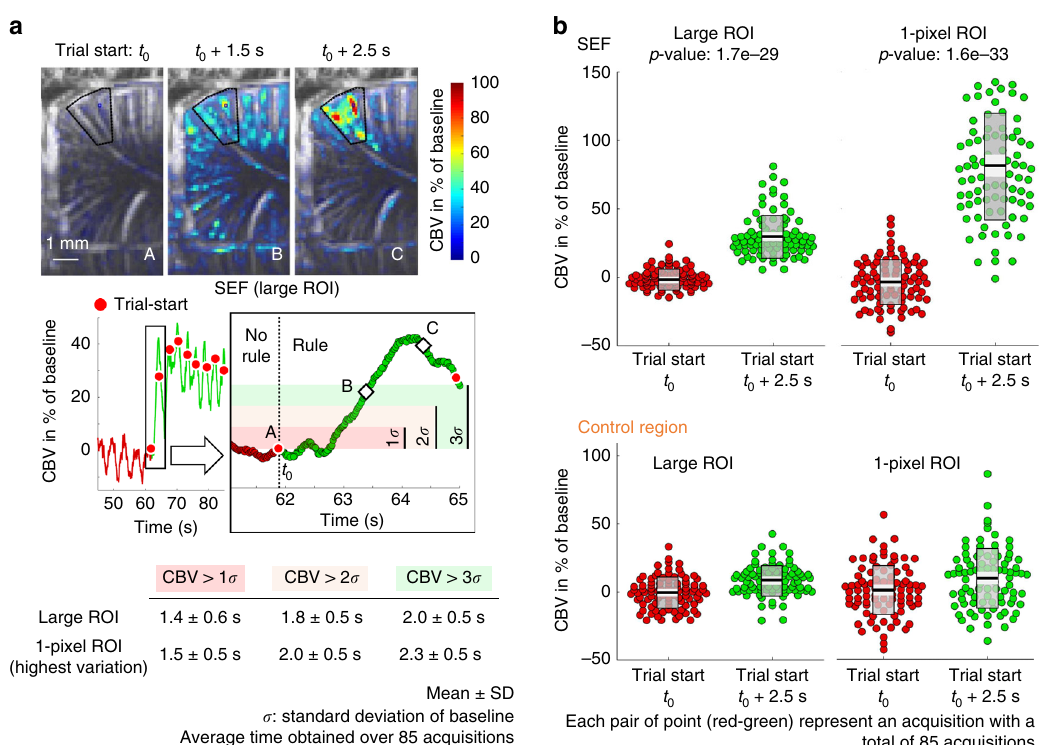
Fig. 2 fUS detect a rule change from the single fi rst trial. a The start of the fi rst visual cue induced a strong CBV variation of ~40% in the SEF reached in 2.5 s (quanti fi ed in a large ROI delineated by a black line, ~240 pixels), and the CBV was already twofold greater than the standard deviation of baseline ( σ ) after 1.5 s. Whether CBV was quanti fi ed in a large ROI or in a 1-pixel ROI (pixel chosen with the highest variation of CBV over the experiment), the delay to observe CBV above a certain range of σ was similar (average over 85 acquisitions). b The CBV variation between the beginning of the fi rst trial and 2.5 s after was highly signi fi cant in the SEF (in the large and 1-pixel ROI), whereas no difference was observed in the control region (paired-sample t -test). Raw data (red and green circles) were summarized with mean (solid black line), 95% con fi dence interval (light gray area), and one standard deviation (transparent gray